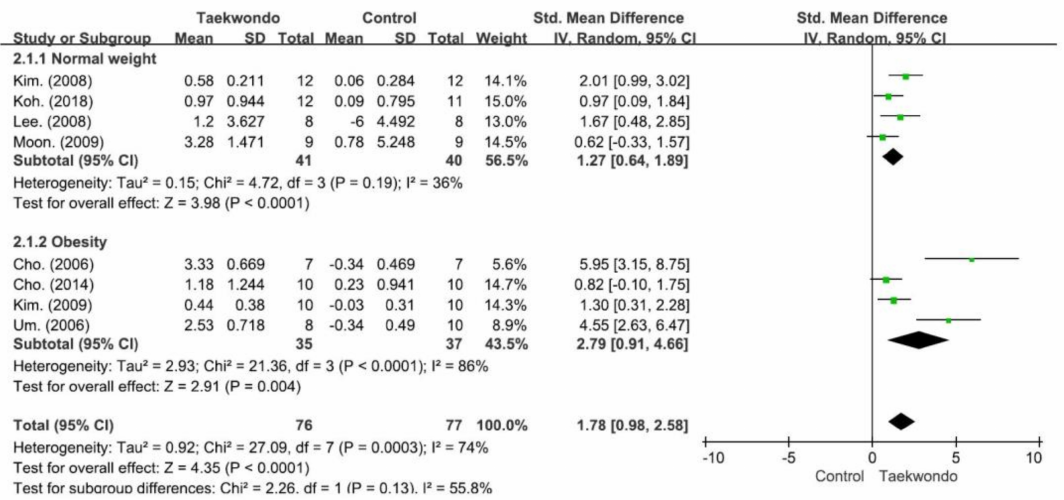
Figure 3. Forest plot depicting differences in the change-from-baseline growth hormone level be- tween the taekwondo and control groups. CI: confidence interval and SD: standard deviation.